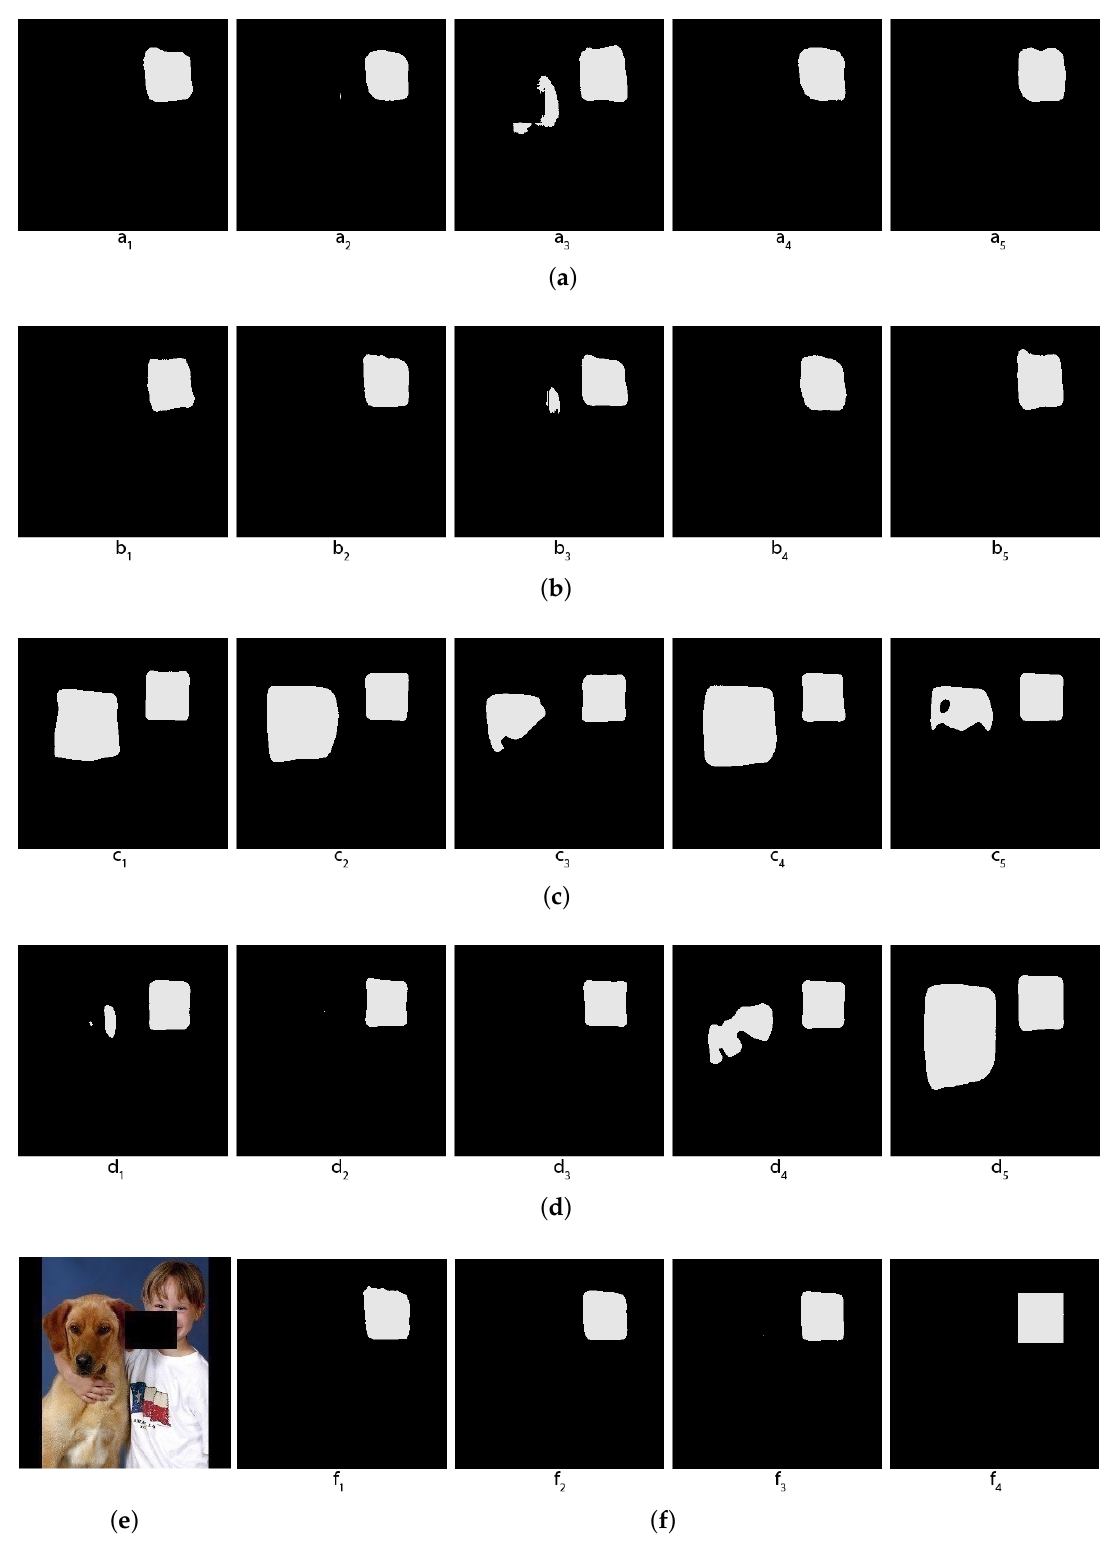
Figure 9. Comparison of voting methods for human faces—The third example. ( a ) Predictions of the first 5 folds (with Mobilenet); ( b ) Predictions of the last 5 folds (with Mobilenet); ( c ) Predictions of the first 5 folds (with EfficienNet); ( d ) Predictions of the last 5 folds (with EfficienNet); ( e ) Original image; ( f ) f 1 : Topological voting, f 2 : Hybrid voting (threshold = 2), f 3 : Arithmetical voting, f 4 : True Mask.